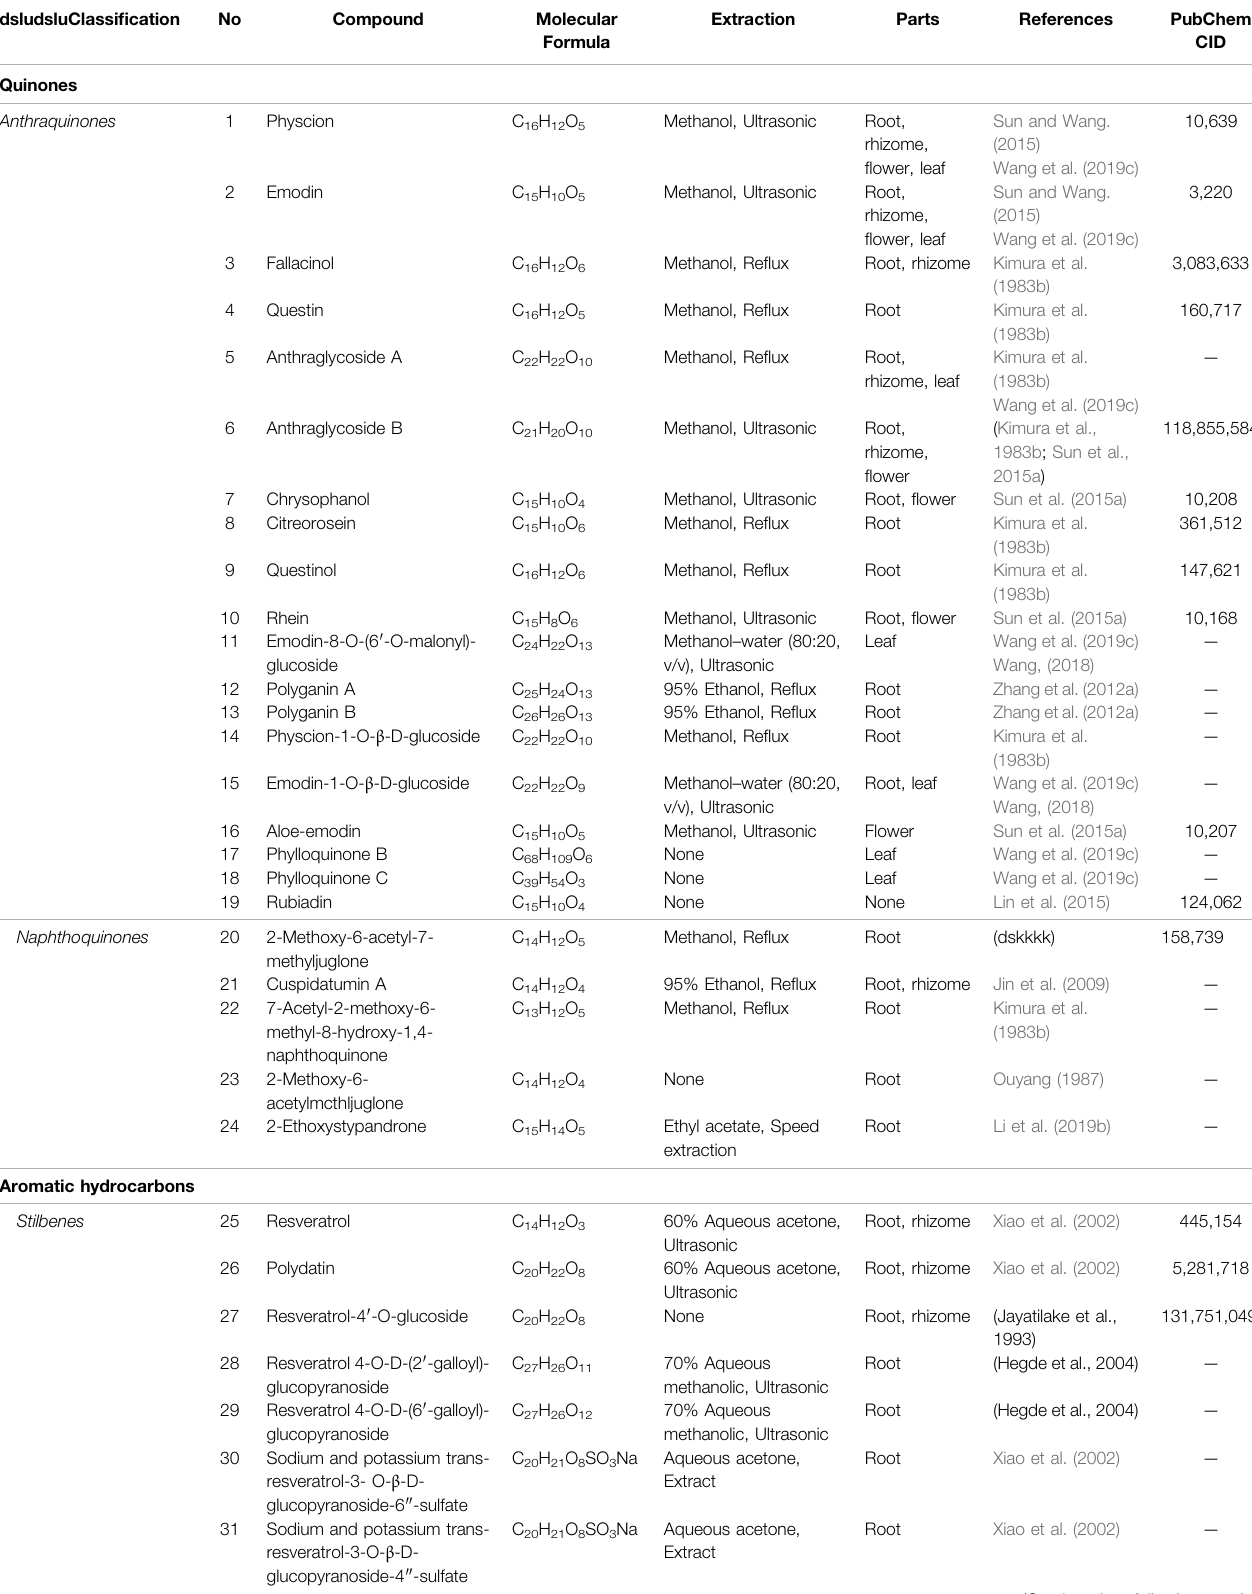
TABLE 3 | Compounds presenting in